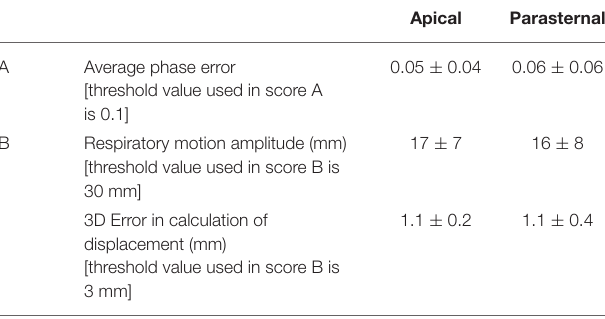
TABLE 3 | Additional detailed results for scores A and B.